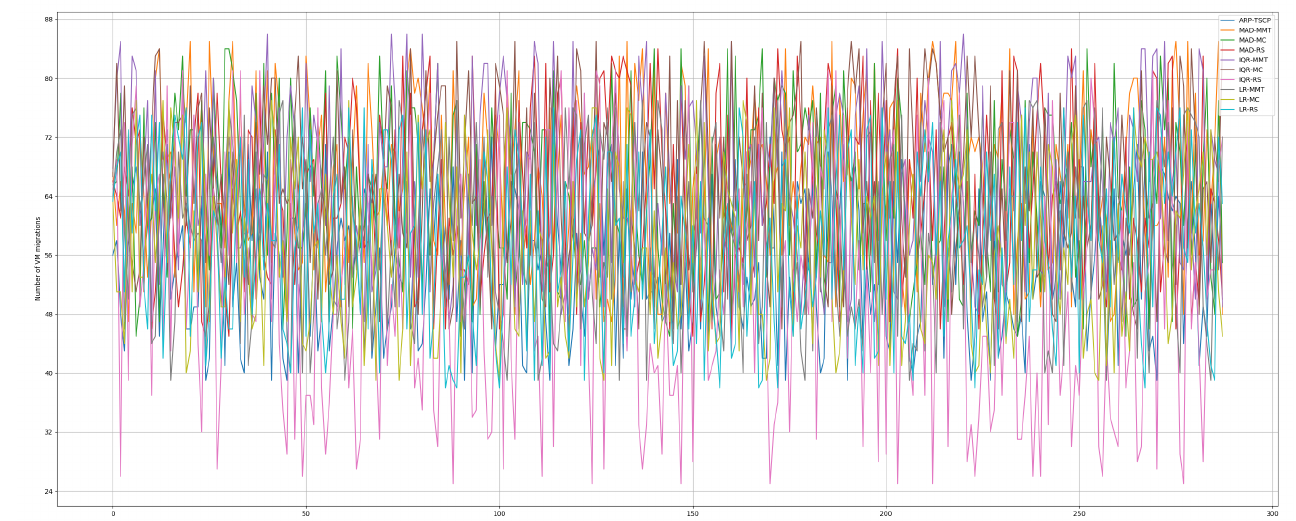
Figure 14. Comparing the number of VM migrations triggered by all methods in every time segment.